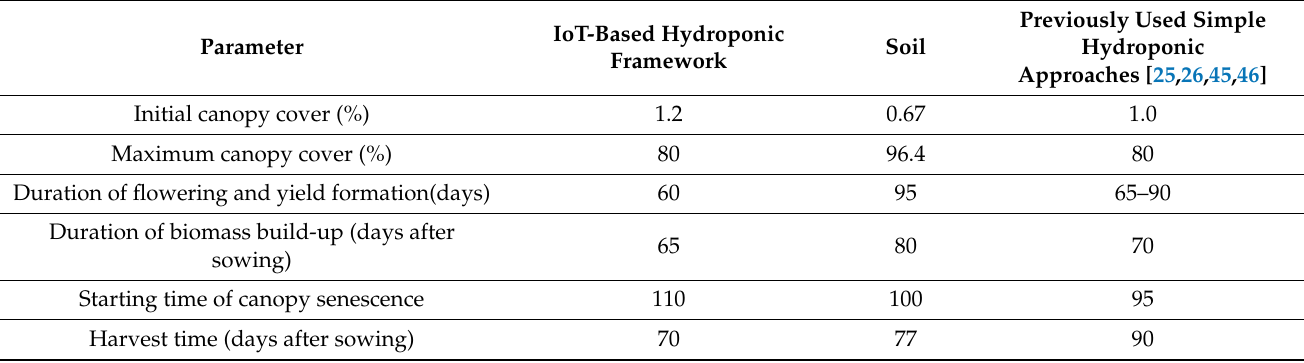
Table 4. Comparison of models based on performance metrics.